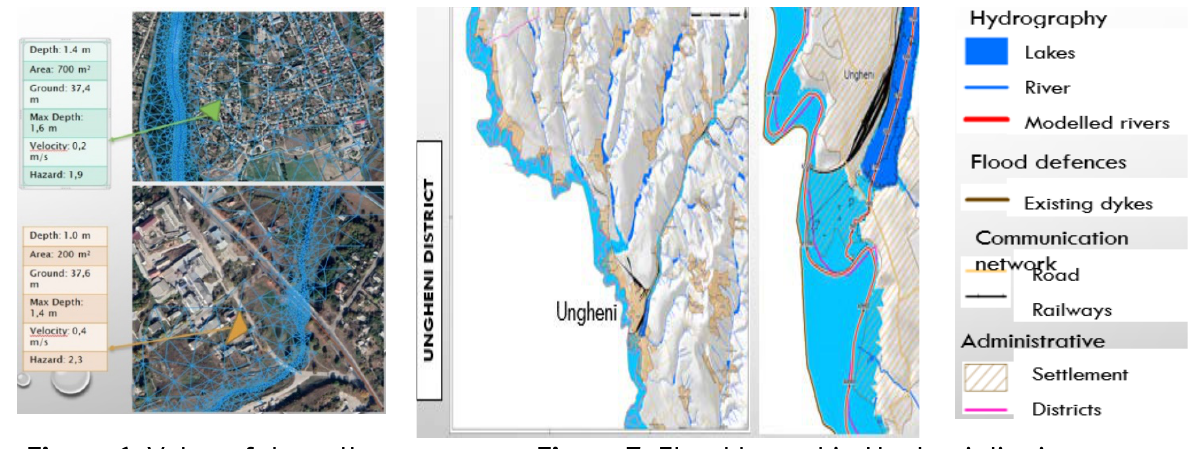
Figure 6. Value of the cells. Figure 7. Flood hazard in Ungheni district.